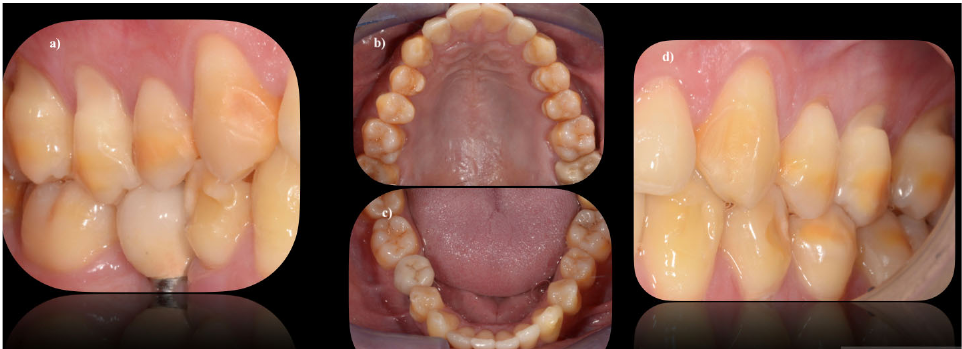
Figure 1. Evident structural enamel defects in a 40-year-old male CeD patient; ( a ) buccal surfaces of the right upper and lower canine, premolar and molar; ( b ) upper dental arch in occlusal view; ( c ) lower dental arch in occlusal view; ( d ) buccal surfaces of the left upper and lower canine, premolar and